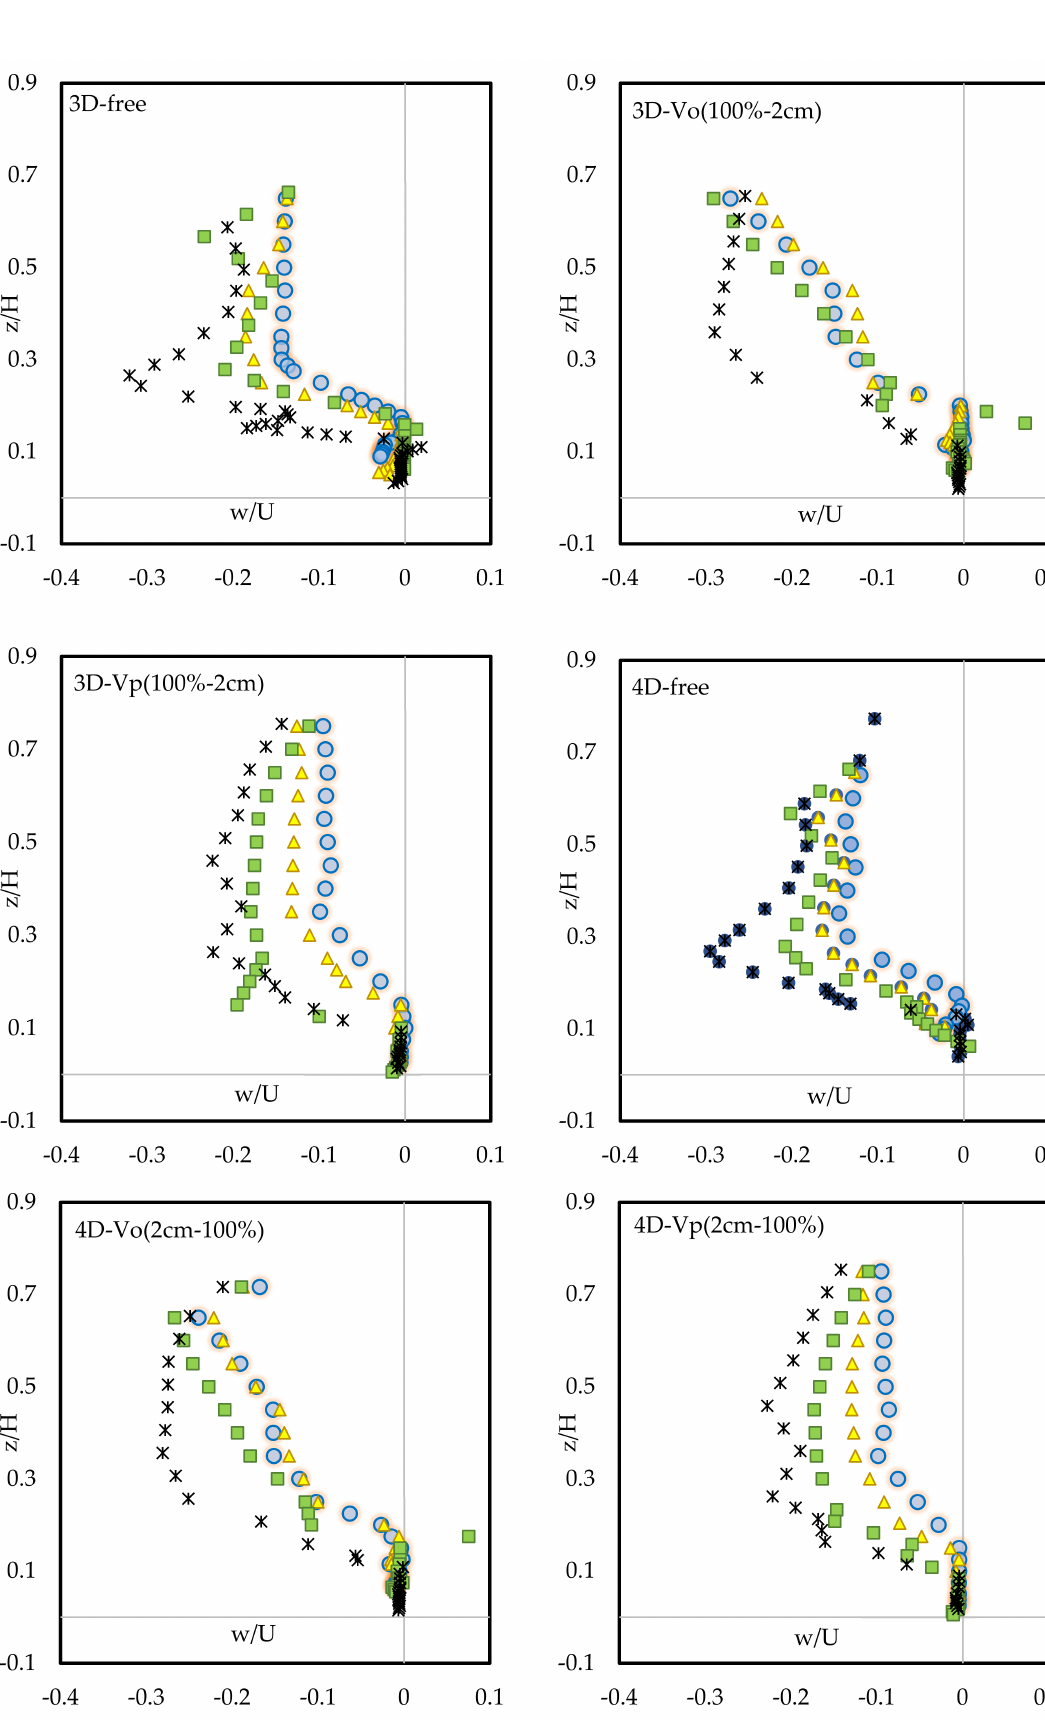
Figure 9. The vertical flow velocity distribution upstream of the first